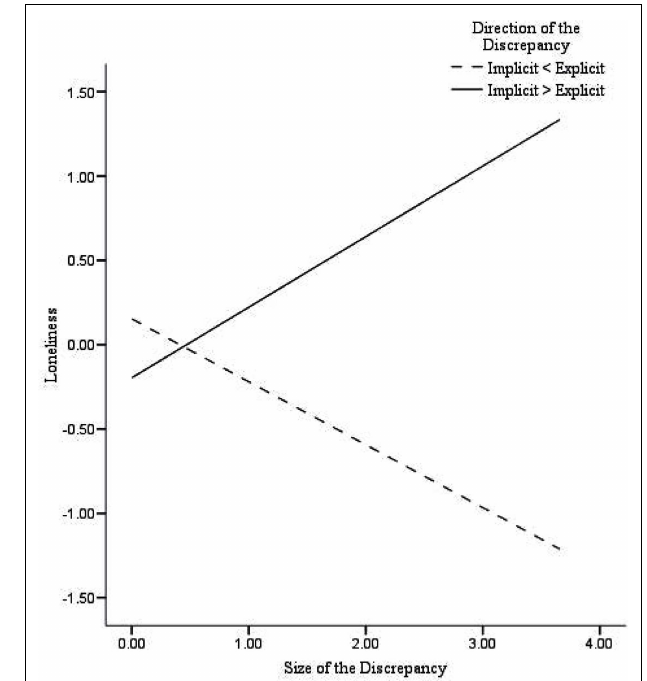
FIGURE 3 | Predicted values for loneliness, illustrating the interaction between the size of the discrepancy and the direction of the